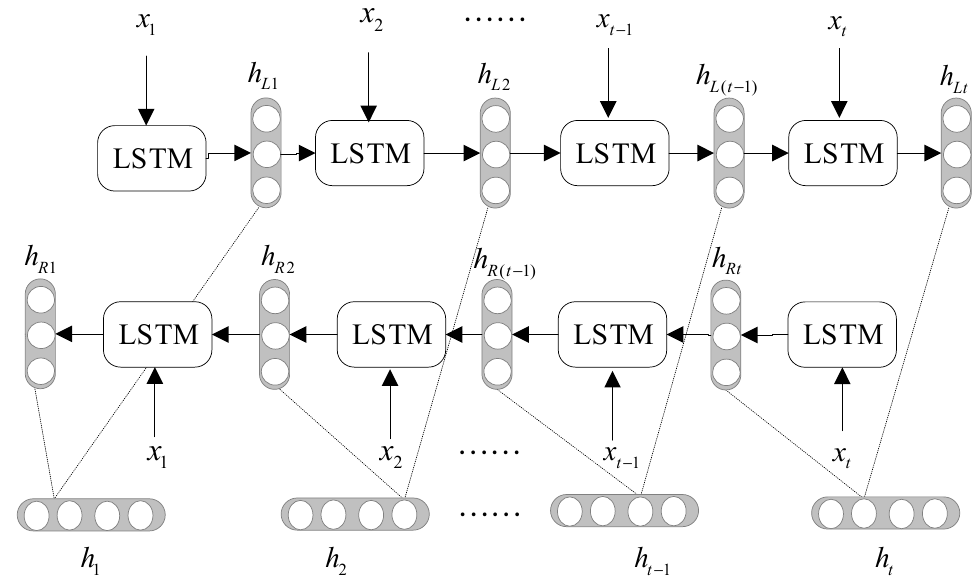
Figure 2. Operation diagram of the bidirectional long-short memory network.